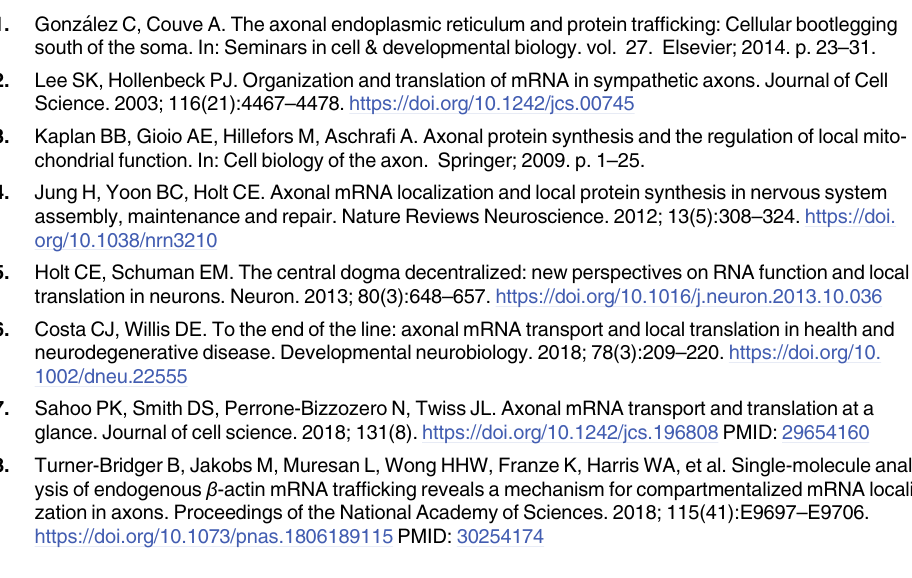
S2 Video. Example trajectory for Space Station (SS) system. Video of example discrete simu- lation run for the model, with n = 5 regions (gray) and M = 100 mitochondria (circles). Color corresponds to mitochondrial health. Stationary mitochondria are shown as solid circles and motile mitochondria as open circles. Mitochondria are produced at the soma (left) and pro- ceed in the anterograde direction until they reflect off the distal end (right), becoming retro- grade